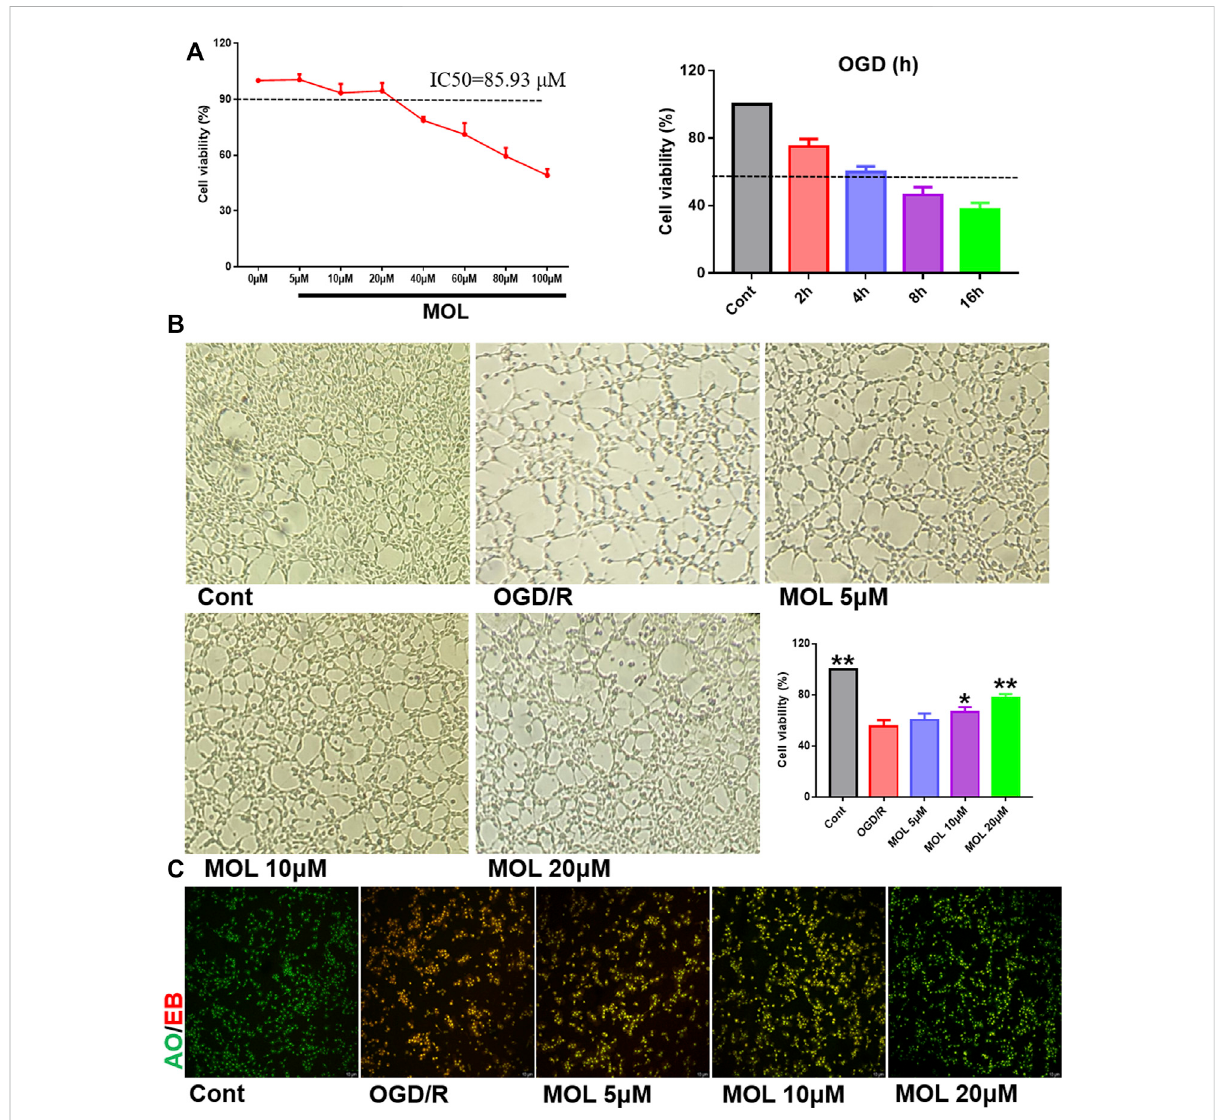
FIGURE 4 MOL protected SHSY-5Y cells from damage caused by OGD/R treatment. (A) Effects of different concentrations of MOL (0 – 100 μ M) on the viability of SHSY-5Y cells, and the effect of different OGD times on cell viability; (B) Effects of different concentrations of MOL (5, 10, 20 μ M) on morphology and viabilityof SHSY-5Y cells treated with OGD/R. (C) AO-EB staining of SHSY-5Y cells treated with differentconcentrations of MOL (5, 10, 20 μ M) and OGD/R. Data expressed as Mean ± SD, ** p < 0.01, * p < 0.05 vs. OGD/R